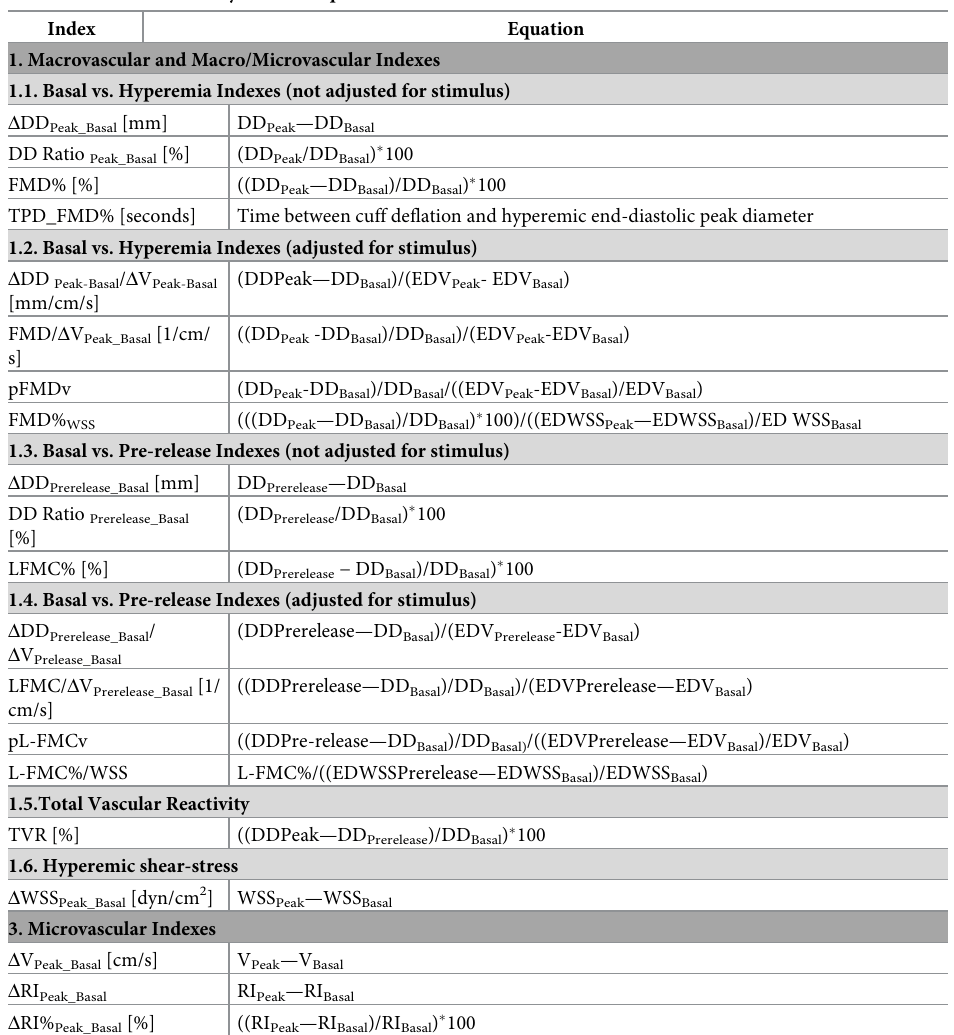
Table 1. Vascular reactivity indexes: